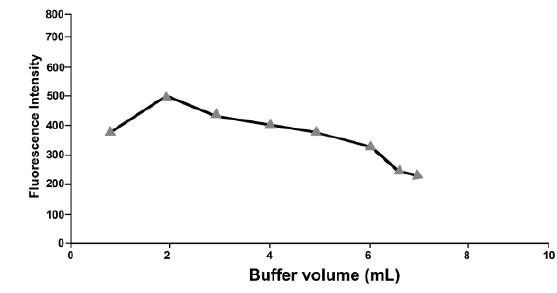
Fig.5. Effect of volume of phosphate buffer (10 mM, pH 6.7) on fluorescence intensity of baricitinib.